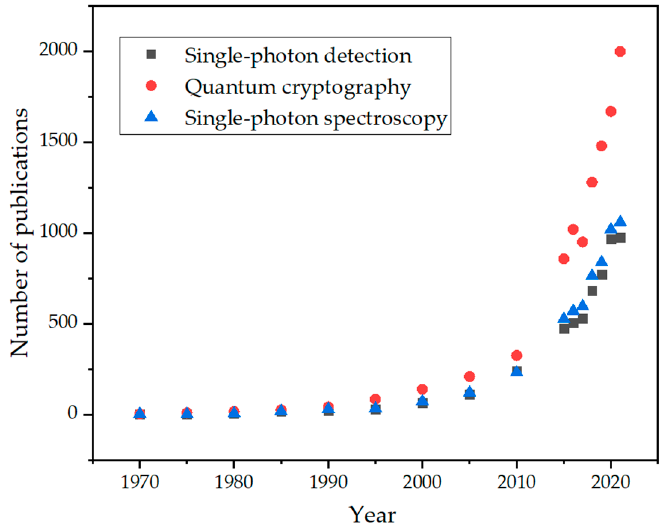
Figure 1. Rising number of publications on mid-infrared photon detectors and their applications in the last 50 years. The number of publications per year was obtained from the Google Scholar database [15], using the keywords “mid-infrared single-photon detection” (black squares), “mid-infrared quantum cryptography” (red circles), and “mid-infrared single-photon spectroscopy” (blue triangles).